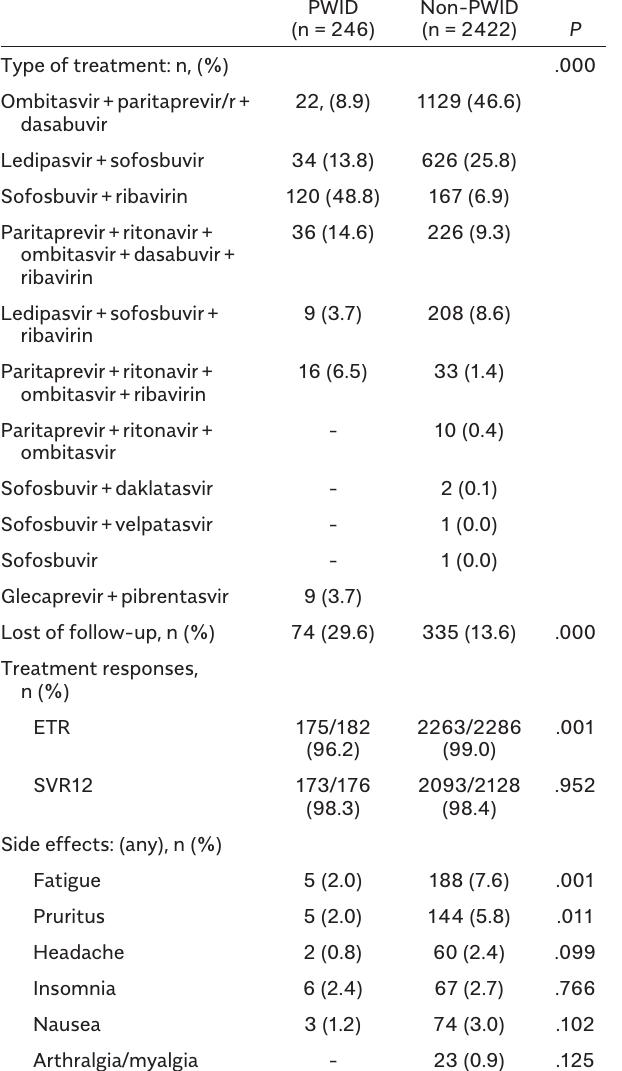
Table 3. Antiviral Treatment Characteristics, Treatment Responses to DAA in PWID Versus Non-PWID